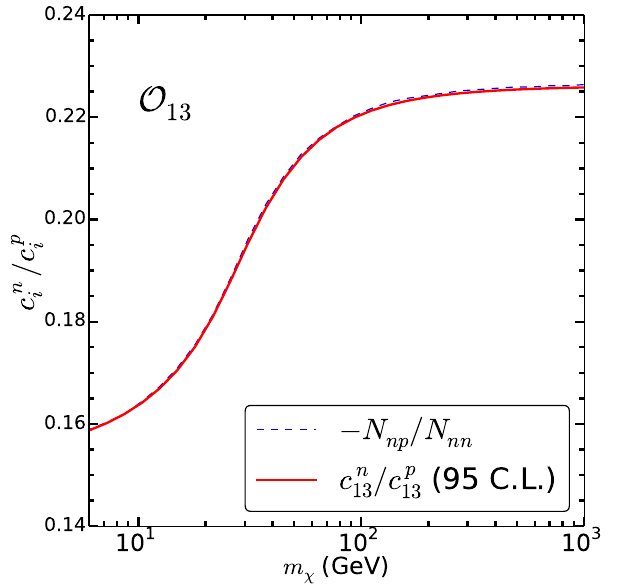
to c p by the minimum condition (blue dashed 13 13